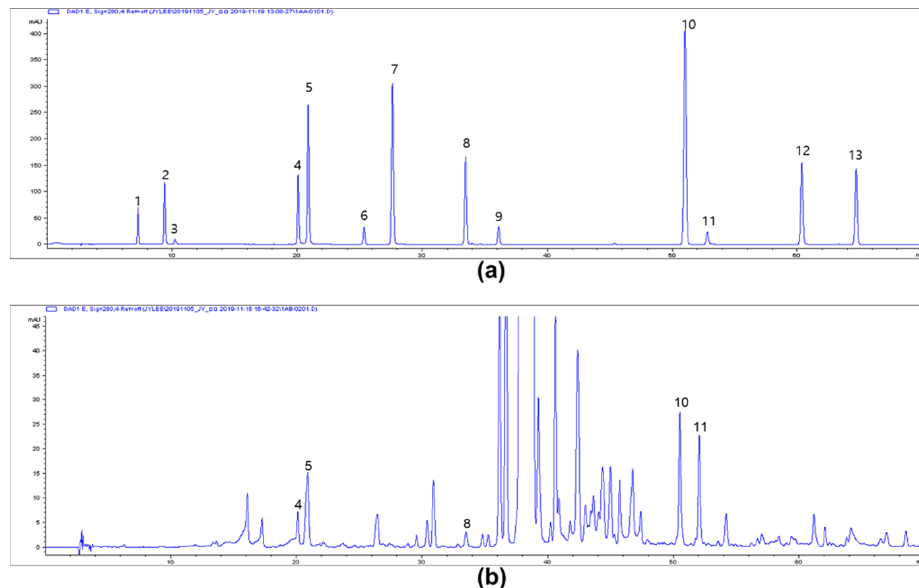
Figure 5. The chromatograms of phenolic compounds from ADE based on HPLC analysis. Peak identification: 1: homogentisic acid, 2: protocatechuic acid, 3: gentisic acid, 4: chlorogenic acid, 5: caffeic acid, 6: phloretic acid, 7: p-coumaric acid, 8: ferulic acid, 9: veratric acid, 10: cinnamic acid, 11: quercetin, 12: naringenin, and 13: hesperidin. Chromatogram of ( a ) standard solution used for